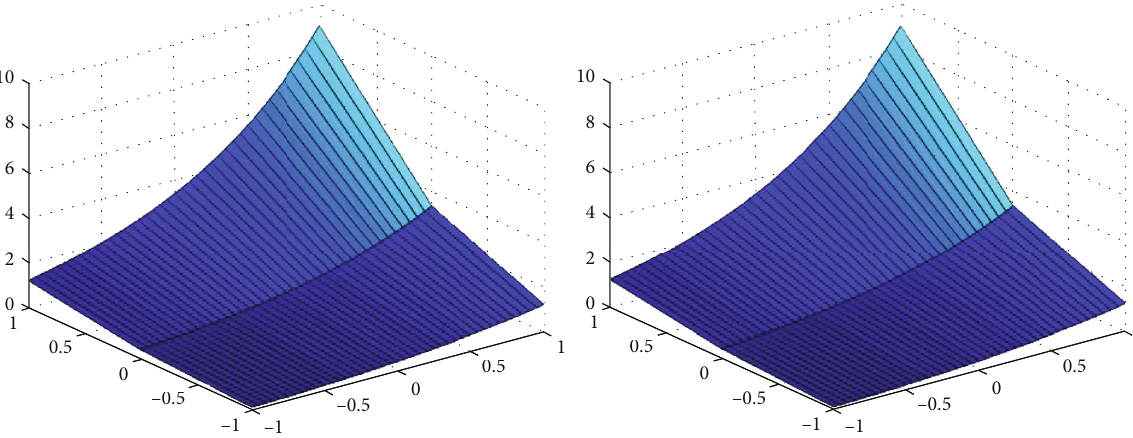
Figure 10: Graph of exact and analytical results of Problem